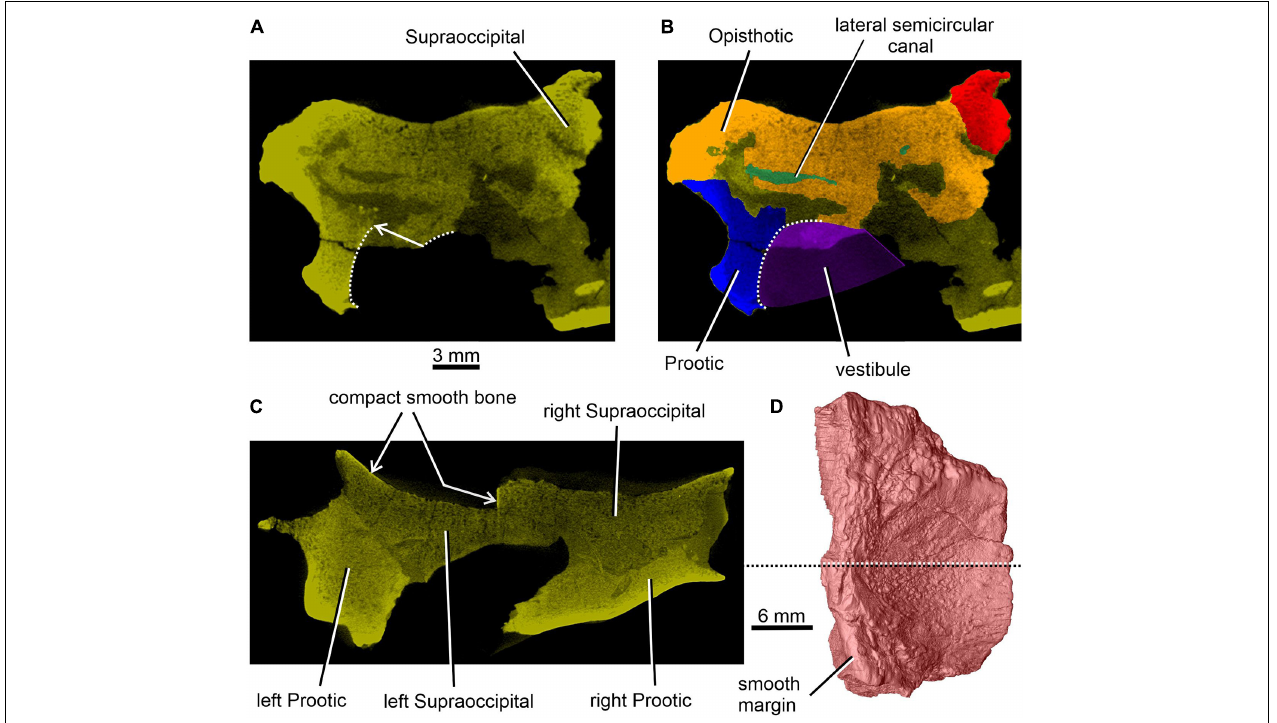
FIGURE 2 | Limnoscelis dynatis , CM 47653. (A,B) Transverse CT section through the posterior portion of the lateral semicircular canal. (C) Transverse CT section through the braincase at about mid-length of the right supraoccipital (D)